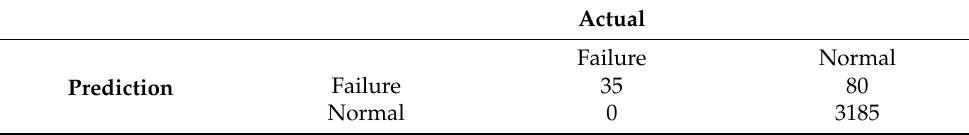
Table 11. Prediction results obtained for PWF diagnosis with the confusion